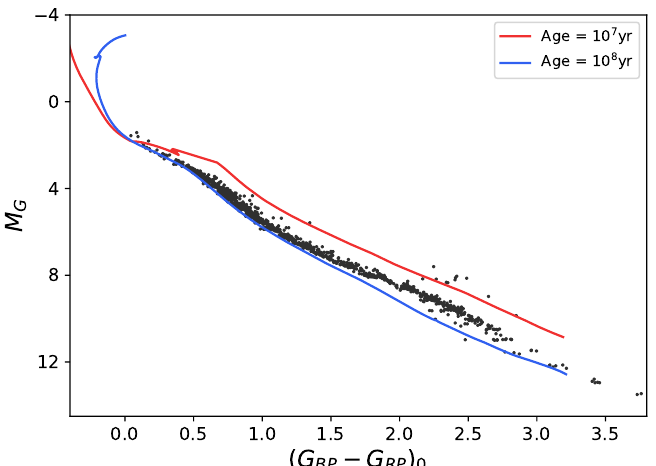
Figure 1. Gaia Hertzsprung-Russell diagram for all our survey targets using Gaia DR3 data. M G denotes the absolute Gaia broadband magnitude after extinction correction and ( G BP − G RP ) 0 the Gaia color after color excess correction. For reference, the interpolated isochrones from MIST website are also